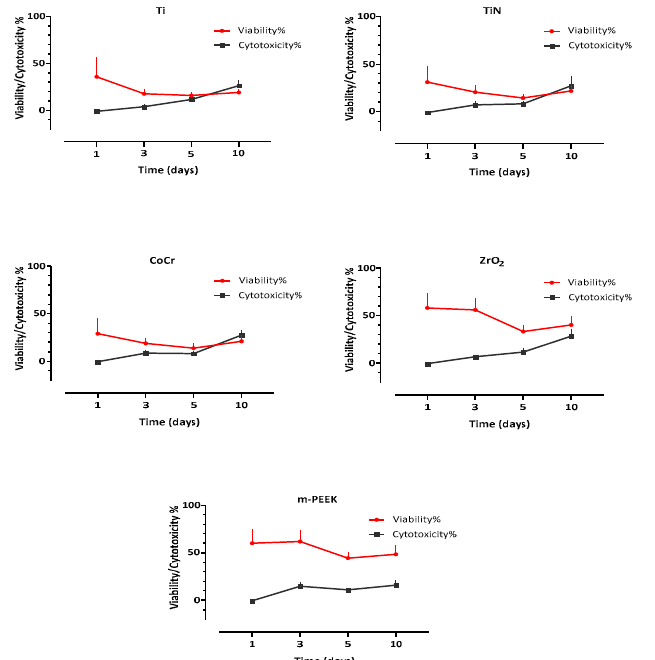
Figure 9. A line plot illustrating a nonsignificant negative correlation between viability and cytotoxicity for all tested materials over 10 days for HGFB.